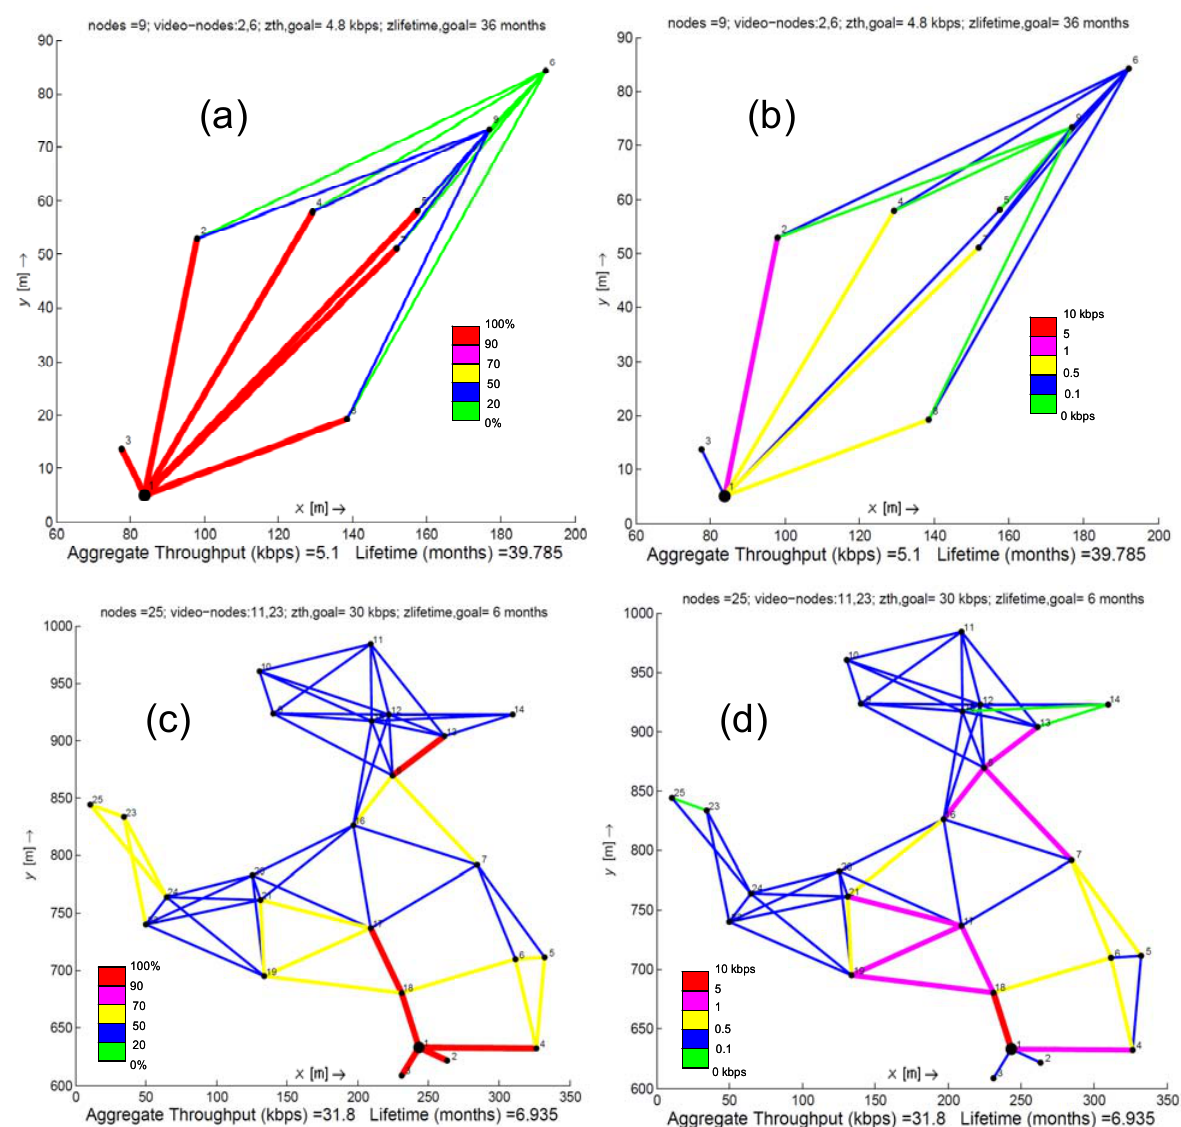
Figure 1. Results obtained for two random topologies consisting of nine and 25 nodes, respectively. Figures 1( a ) and 1( c ) present the % traffic load distributed by each node. Figures 1( b ) and 1( d ) plot the achieved throughput per link